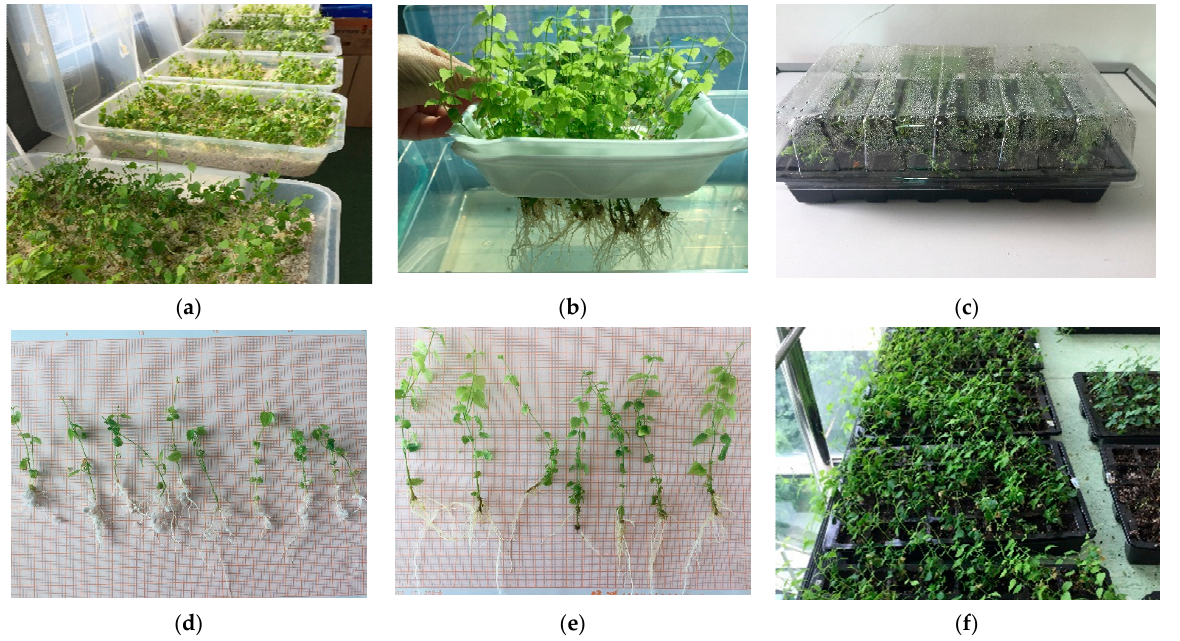
Figure 3. Ex vitro acclimatization of Humulus lupulus , cv. Cascade: ( a ) Acclimatization in perlite. ( b ) Acclimatization in float hydroculture. ( c ) Acclimatization in covered cell trays in peat + perlite substrate (3:1, v / v ). ( d ) Plants rooted ex vitro and acclimatized in perlite. ( e ) Plants rooted in vitro and subsequently acclimatized in float hydroculture. ( f ) Plants acclimatized in peat-based substrate. Table 2. Number and size range of amplified fragments generated by RAPD and SCoT markers in H. Lupulus cv.